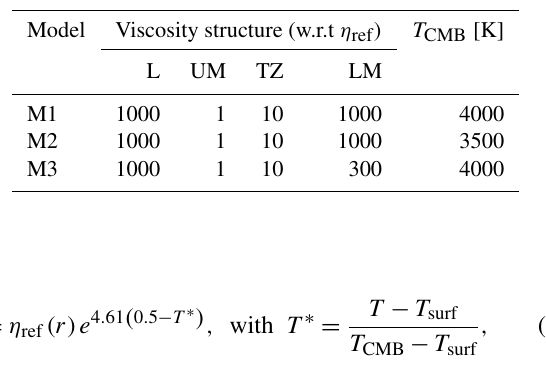
Table 2. Key parameters of models M1, M2 and M3. Only the viscosity profile (Fig. 2) and the temperature at the core–mantle boundary (CMB) have been varied. The viscosity structure refers to a reference viscosity η ref of 1020Pas and comprises different viscosities for the following radial mantle layers: lithosphere (L), upper mantle (UM), transition zone (TZ) and lower mantle